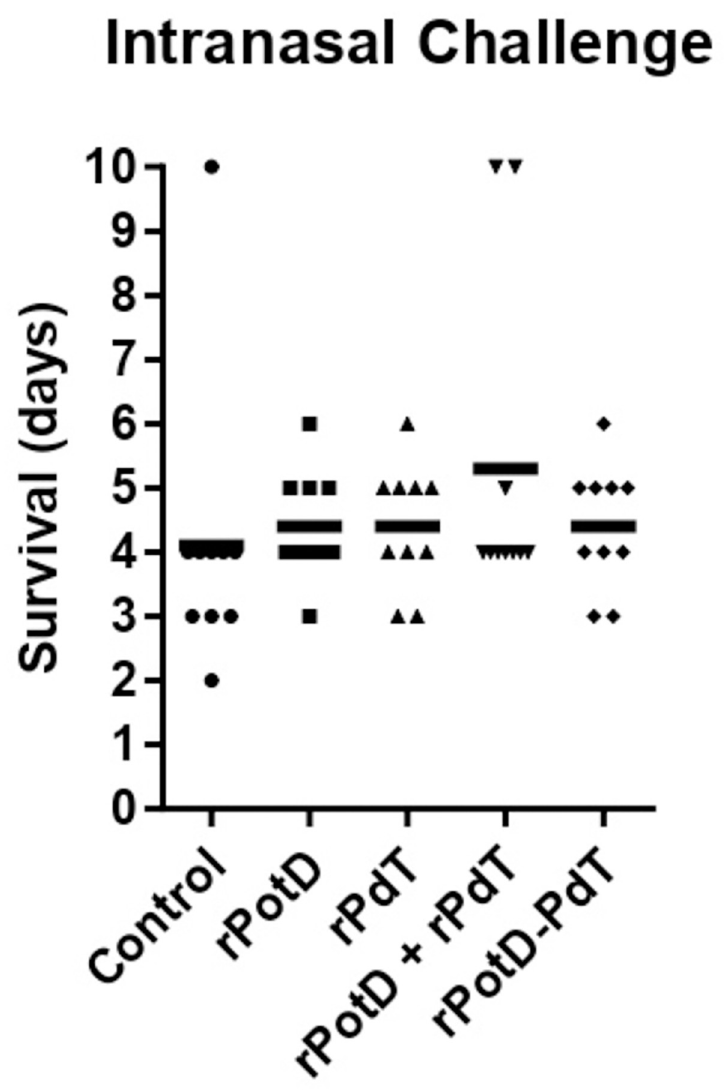
Fig 6. Survival times (days) for mice after intranasal challenge. Groups of 10 BALB/c mice were immunized subcutaneously with the indicated antigens and challenged intranasally 7 days after the third immunization with St ATCC6303 (3.6 × 104 CFU). Each dot represents one mouse. The horizontal lines denote the median survival time for each group. Control group is composed by animals injected with adjuvant in saline